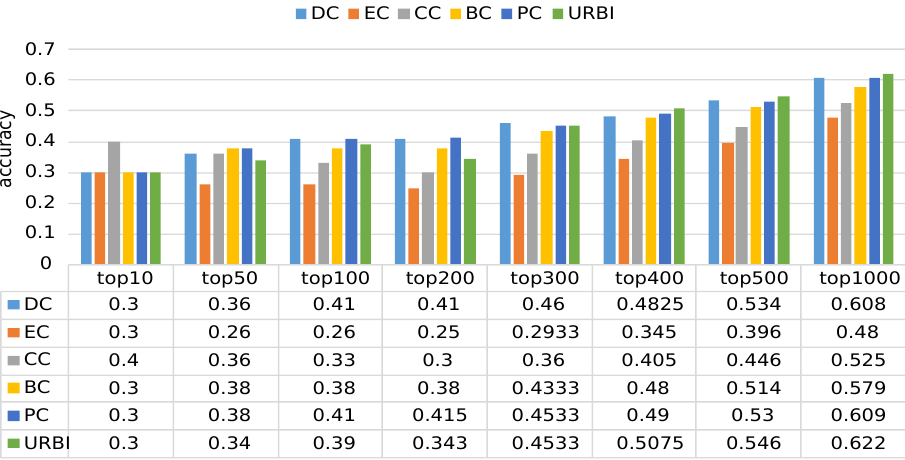
Figure 2. This figure depicts the experimental results of dataset No.2, which contains 6528 book nodes.